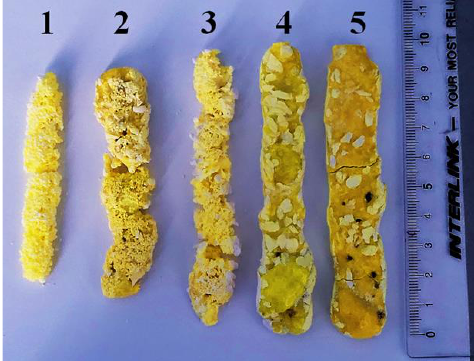
Figure 4. Photographs of YAG:Ce ceramic samples synthesized under the influence of electron fluxes of different E and P: 1—E = 1.4 MeV, P = 2.5 kW/cm 2 ; 2—E = 2.0 MeV, P = 4 kW/cm 2 ; 3—E = 2.5 MeV, P = 8 kW/cm 2 ; 4—E = 2.0 MeV, P = 6 kW/cm 2 ; 5—E = 2.5 MeV, P = 10 kW/cm 2 . The samples formed inside the mixture, at a relatively low power density P, have a shorter length and a porous surface. Ceramic samples that reached the surface of the mixture during the formation of ceramics have a solid surface but are porous inside.